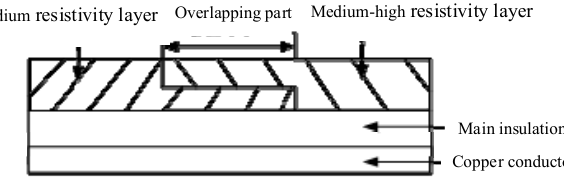
Figure 3. Schematic of the overlapping structure of a corona protection layer.